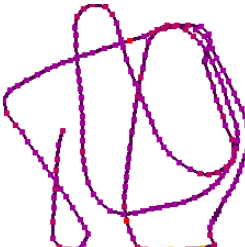
Figure 3. Example of a trawling trajectory that has been transformed into an